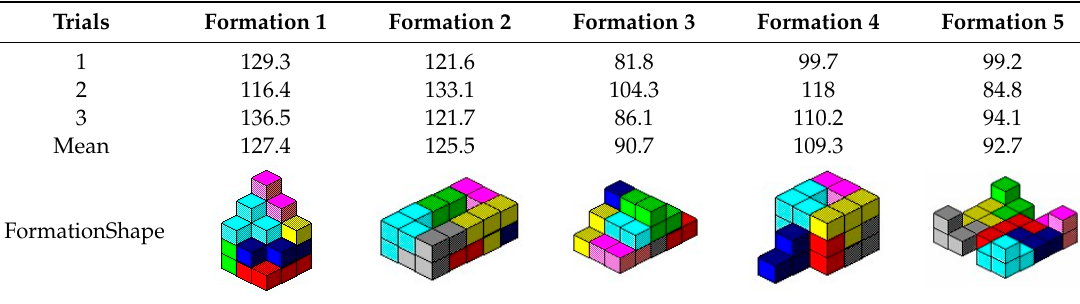
Table 2. Computation time in seconds of planning for three different assembly formations. Trials